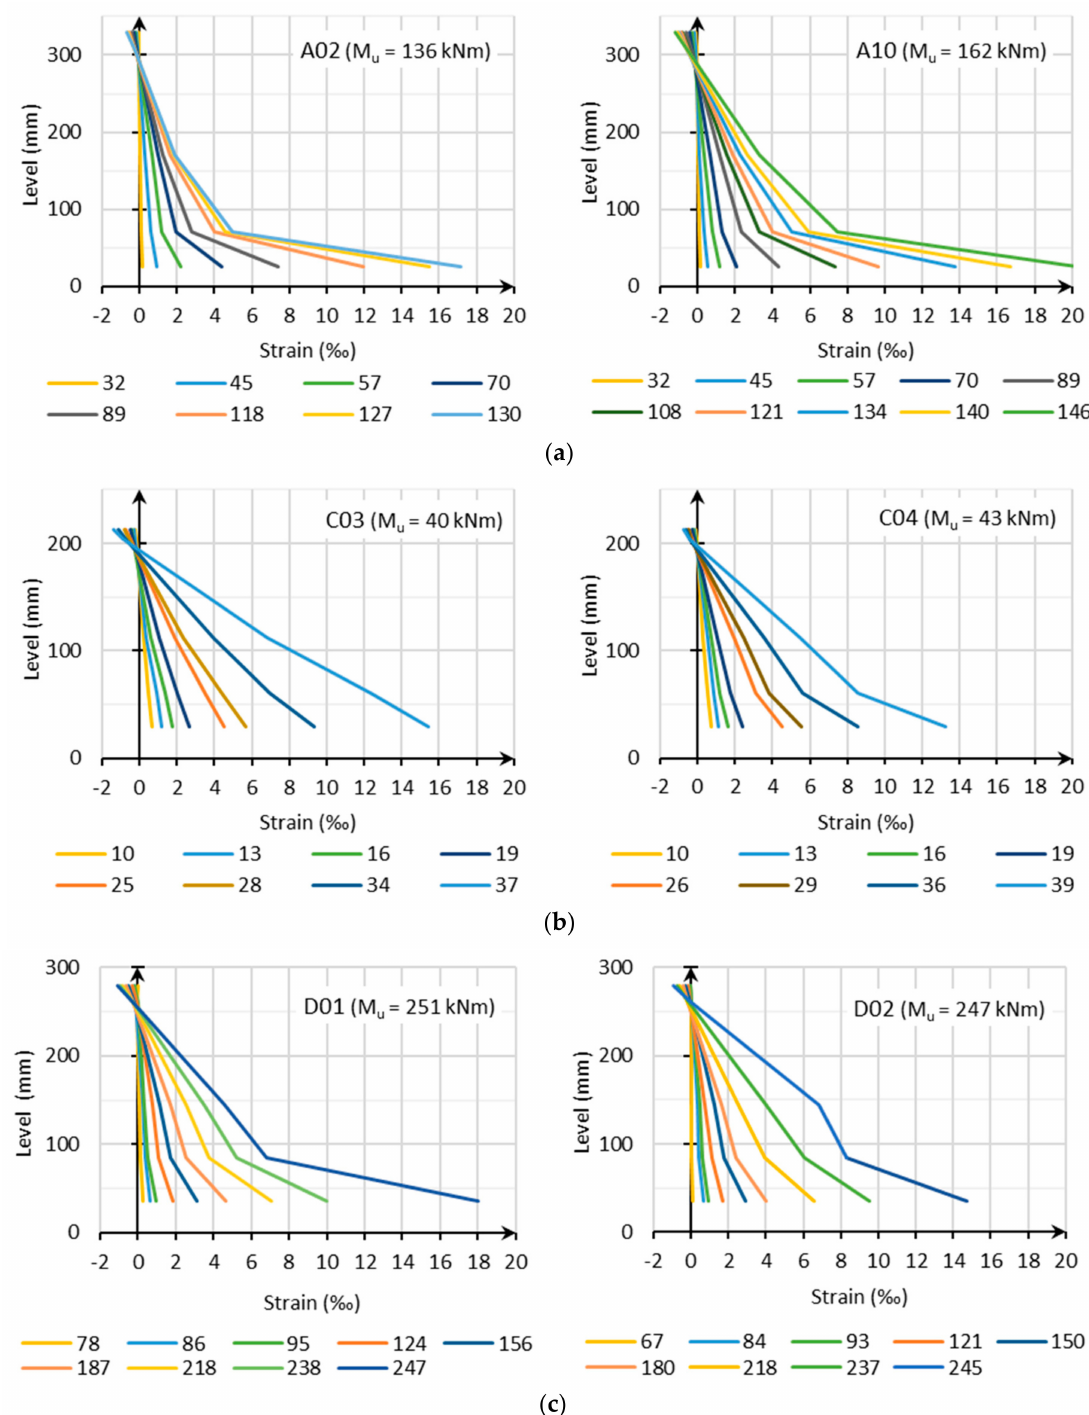
Figure 7. Deformation of the cross-section at midspan at different levels of the total applied moment for ( a ) A-series (A02 and A10); ( b ) C-series (C03 and C04); ( c ) D-series (D01 and